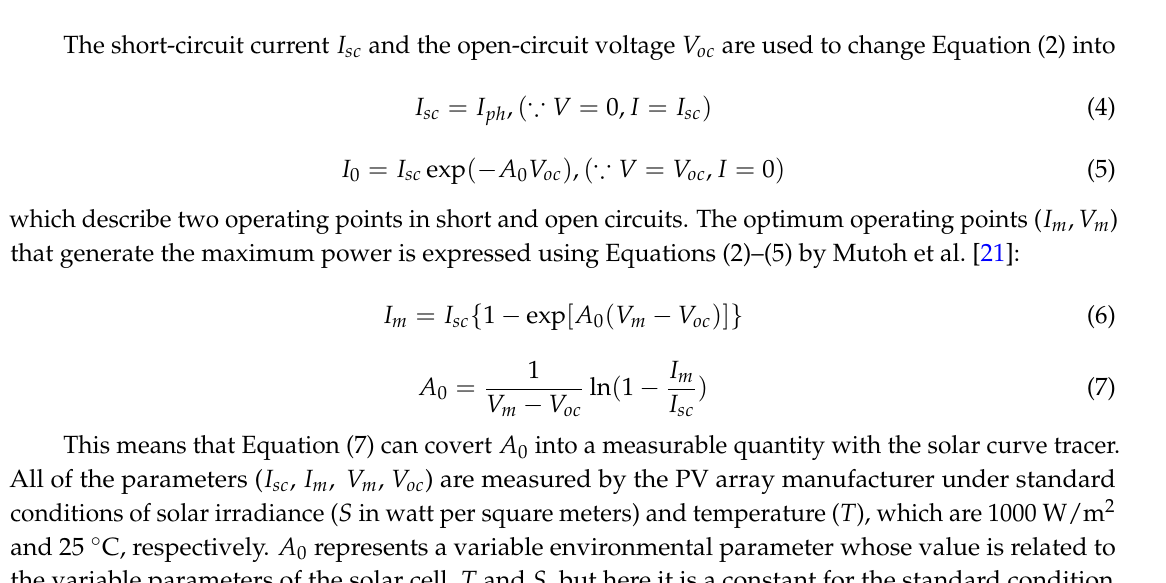
Figure 1. Equivalent circuit of the photovoltaic (PV) module.